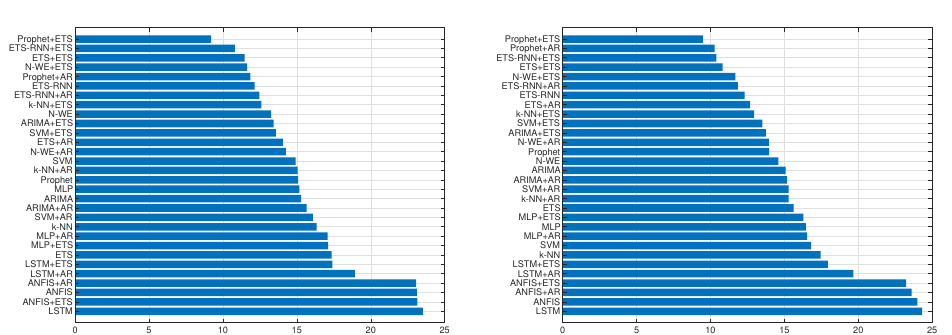
Figure 9. MAPE for each country.